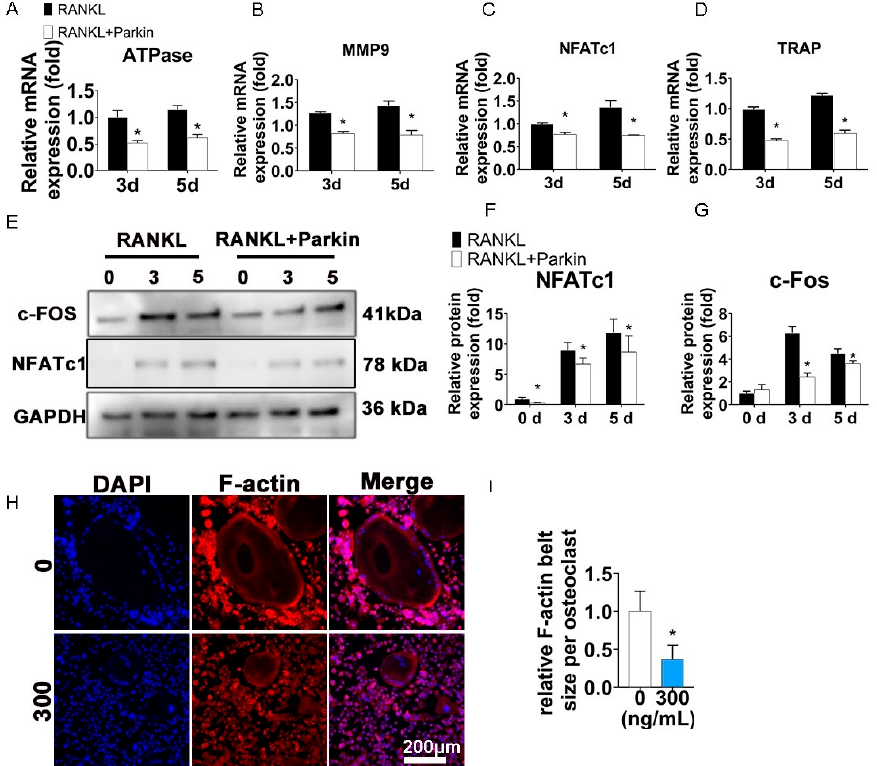
Figure 3. Parkin attenuates osteoclast-specific markers and RANKL-induced F-actin ring formation in vitro. ( A – D ) After BMMs were exposed to RANKL (100 ng/mL), M-CSF (30 ng/mL), and Parkin (300 ng/mL) for 3 or 5 days, the mRNA levels of osteoclast-specific genes were significantly sup- pressed by Parkin. ( E – G ) Parkin suppressed NFATc1 and c-Fos protein levels (0, 3, and 5 days of osteoclastogenesis). After BMMs were exposed to Parkin (300 ng/mL) for 1 day without RANKL and MCS-F, the NFATc1 results of WB at day 0 were analyzed. * p < 0.05 compared with the control group (0 ng/mL Parkin). ( H , I ) F-actin ring staining for osteoclasts. BMMs were treated with Parkin (300 ng/mL) during osteoclastogenesis for 5 days. * p < 0.05 compared with the control group (0 ng/mL Parkin).